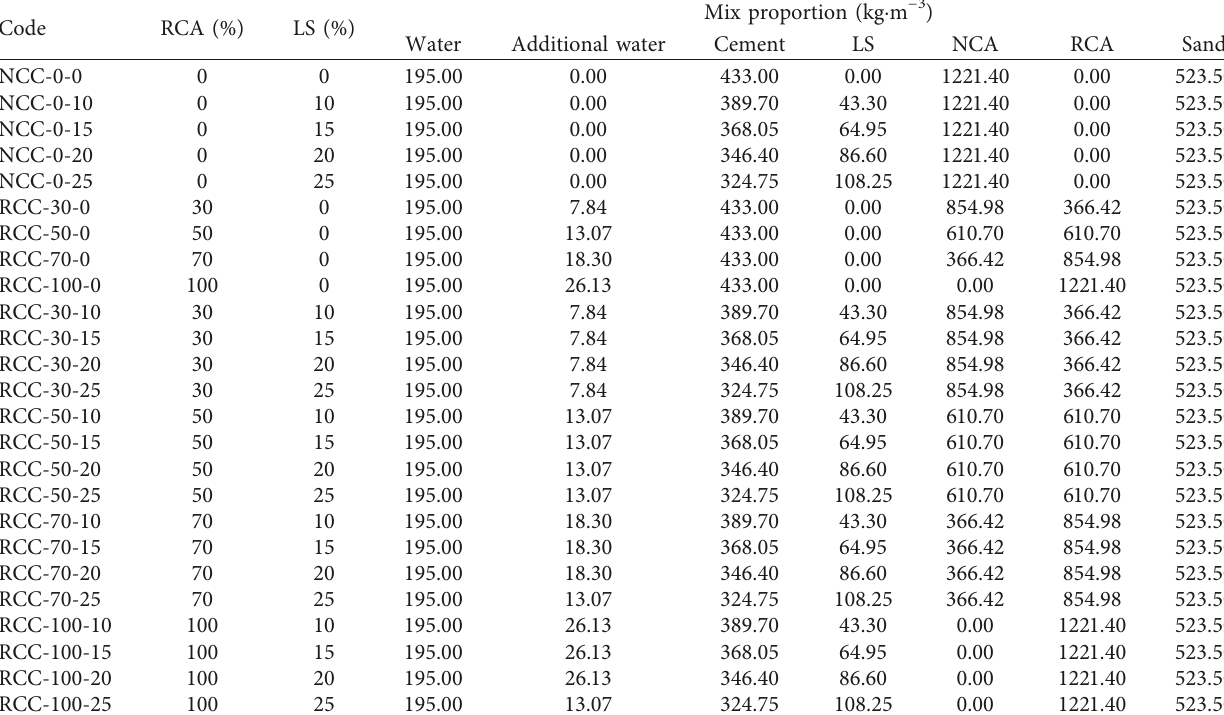
Table 3: The design of mix proportion.